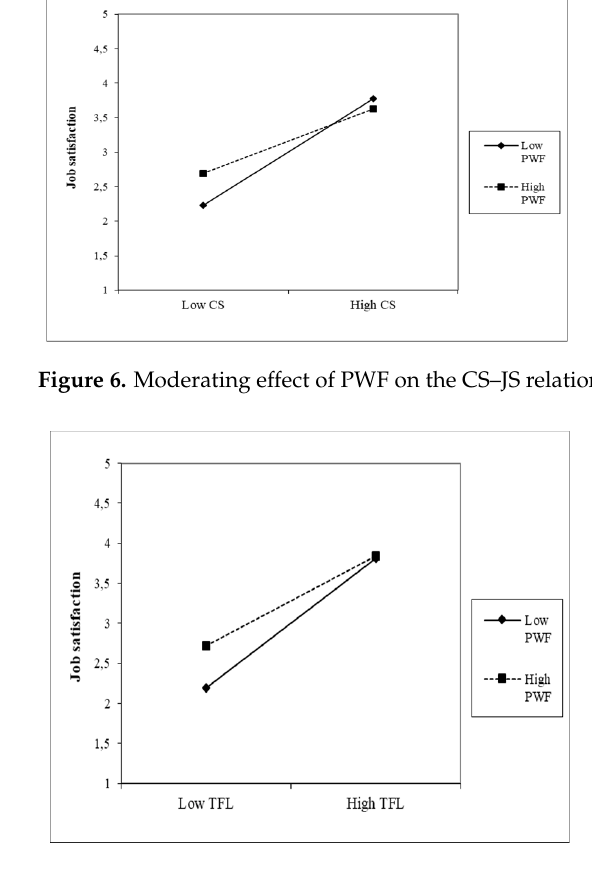
Figure 5. Moderating effect of the span of control on the TFL–JS relationship.